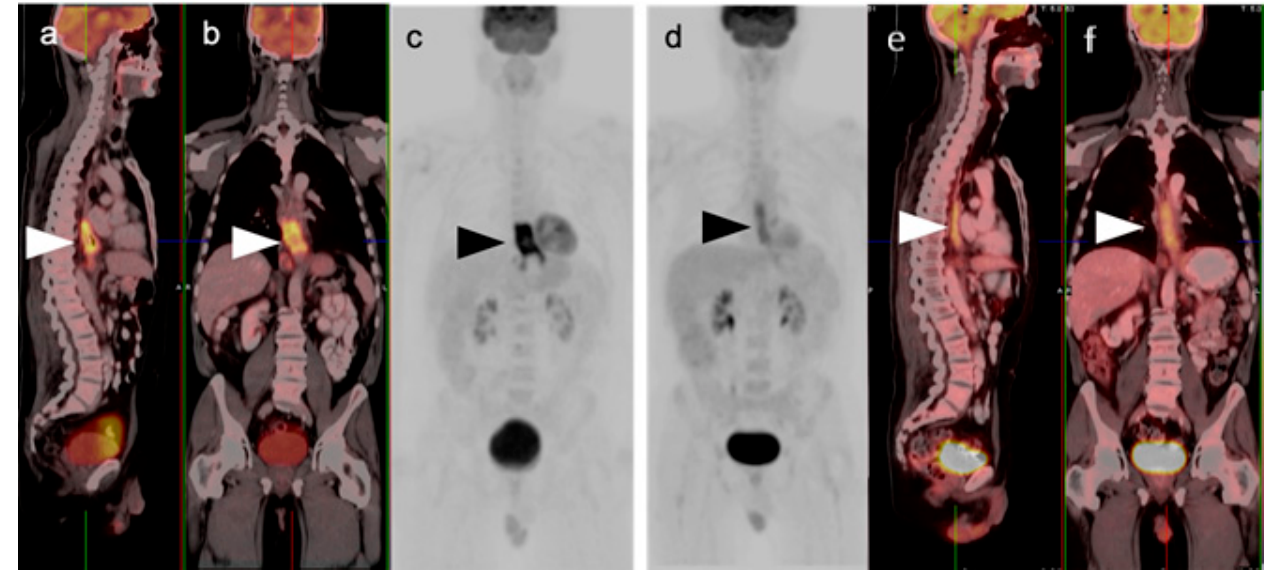
Figure 1. Pre- and post-treatment esophageal cancer. ( a – f ) FDG PET-CT pre-treatment for esophageal cancer. Sagittal ( a ), coronal ( b ) and anterior maximum intensity projection (MIP) ( c ) images show a hypermetabolic distal esophageal carcinoma (arrowheads); ( d – f ) Post-treatment esophageal cancer in the same planes as the pre-treatment scan. Repeat FDG PET-CT 3 weeks following completion of neoadjuvant chemoradiation show mild persistent metabolic activity through the radiation field (arrowheads). Imaging at 10–12 weeks post-completion of chemoradiation is recommended to minimize false FDG PET-CT findings such as these, due to post-treatment inflammatory changes.